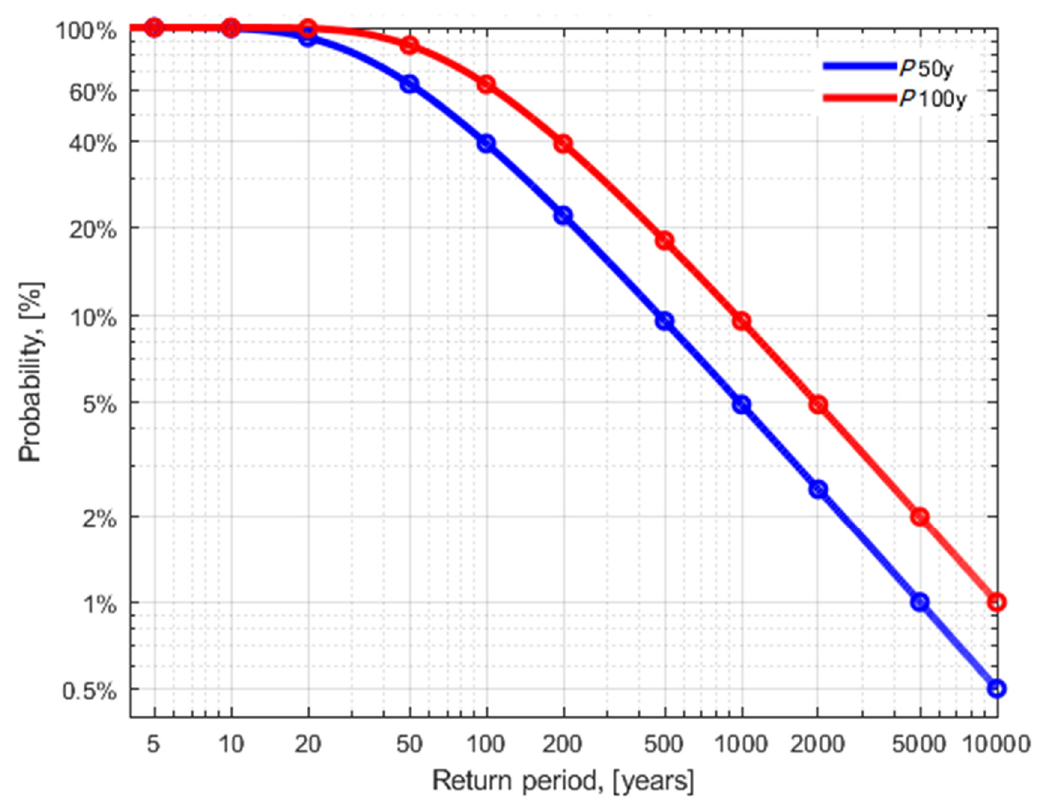
Figure 2. The 50- and 100-yr exceedance probabilities as functions of return